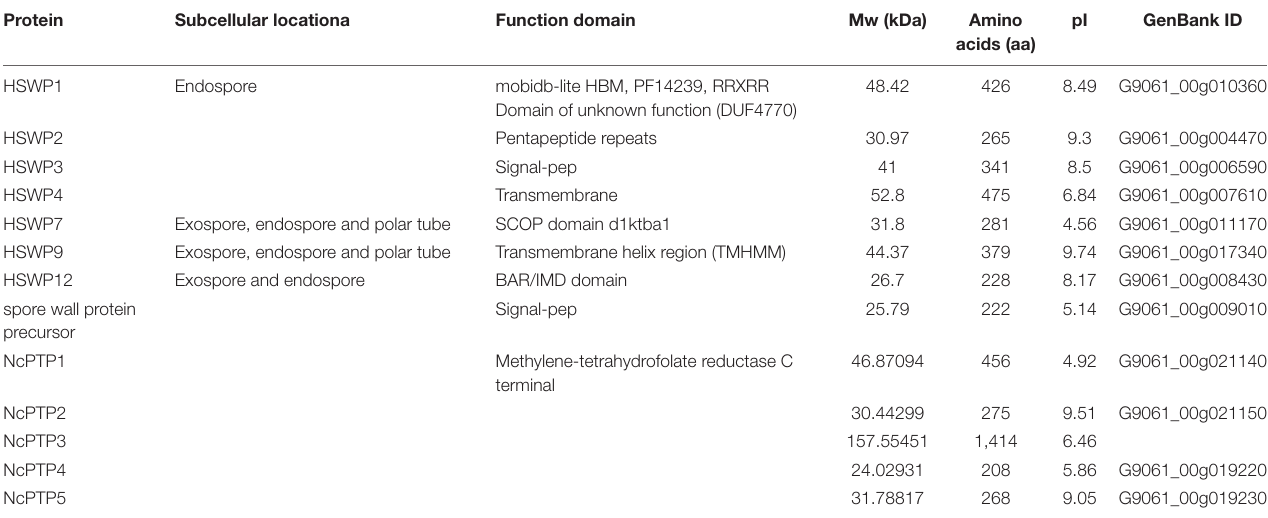
TABLE 3 | The identified spore wall proteins and Polar tube proteins of Nosema ceranae